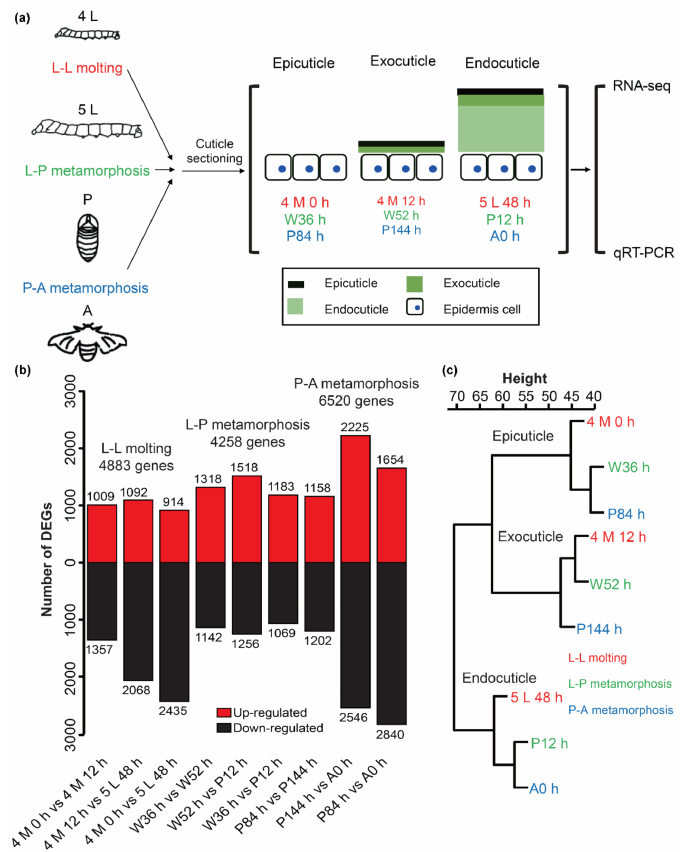
Figure 2. Sample collection and analysis of transcriptomes in B . mori. ( a ) Sample collection of transcriptomes. The epicuticle, exocuticle, and endocuticle in the top represented the developmen- tal stages associated with epicuticle, exocuticle, and endocuticle depositions, respectively. qRT- PCR: real-time fluorescent quantitative PCR. ( b ) Statistics of differentially expressed genes (DEGs). ( c ) Cluster dendrogram showing a global relationship between different samples. Hierarchical cluster analyses of nine samples was performed based on the expression levels of DEGs. The x -axis is the degree of